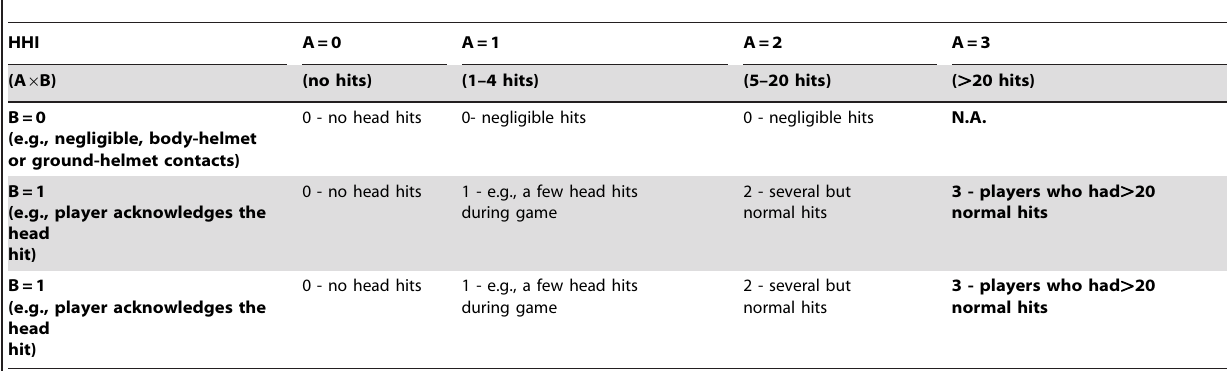
Table 1. Parameters of Head Hit Index (HHI) calculations.